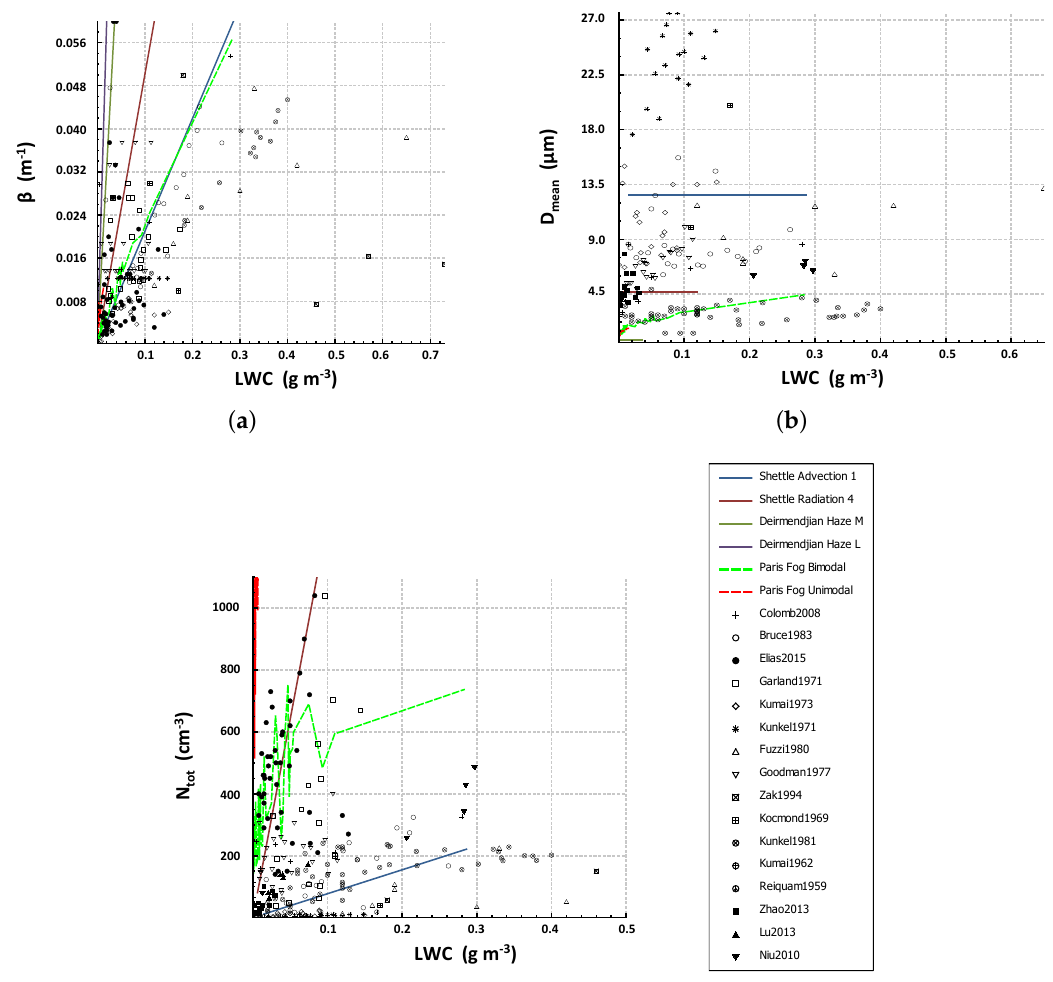
Figure 6. Relation between fog droplets parameters as given from the literature (symbols), calculated from Paris Fog data (dashed lines), or from models (continous line). ( a ) β vs. LWC . ( b ) D mean vs. LWC . ( c ) N tot vs. liquid water content ( LWC ). ( d )